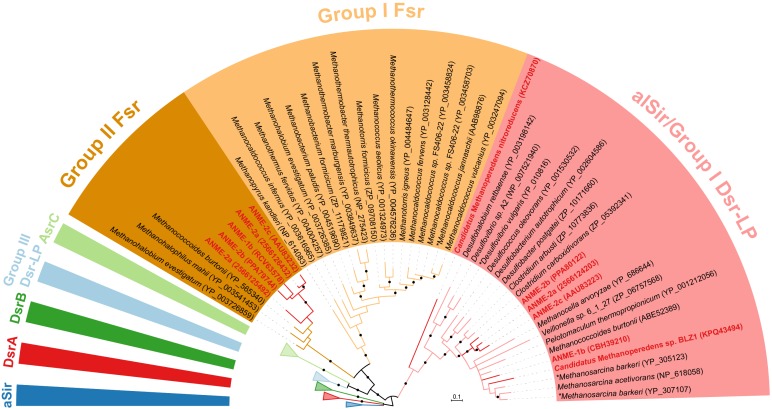
Bayesian phylogeny of sulfite reductases. Two well-supported groups of Fsr were identified in exclusion of alSir and other sulfite reductases. ANME proteins are bolded in red. The phylogenetic tree was constructed based on 224 amino acid residues of the shared catalytic and siroheme-binding region. Asterisks (∗) indicate proteins that have been studied biochemically (Huynh et al., 1984; Moura et al., 1986; Johnson and Mukhopadhyay, 2005). Protein accession numbers from the NCBI database or gene IDs from the IMG database are shown in parentheses. Black dots on the branches represent Bayesian posterior probability values greater than 90%, and scale bar indicates the number of amino acid substitutions per site. The fully expanded tree can be found be found in Supplementary Figure 1.